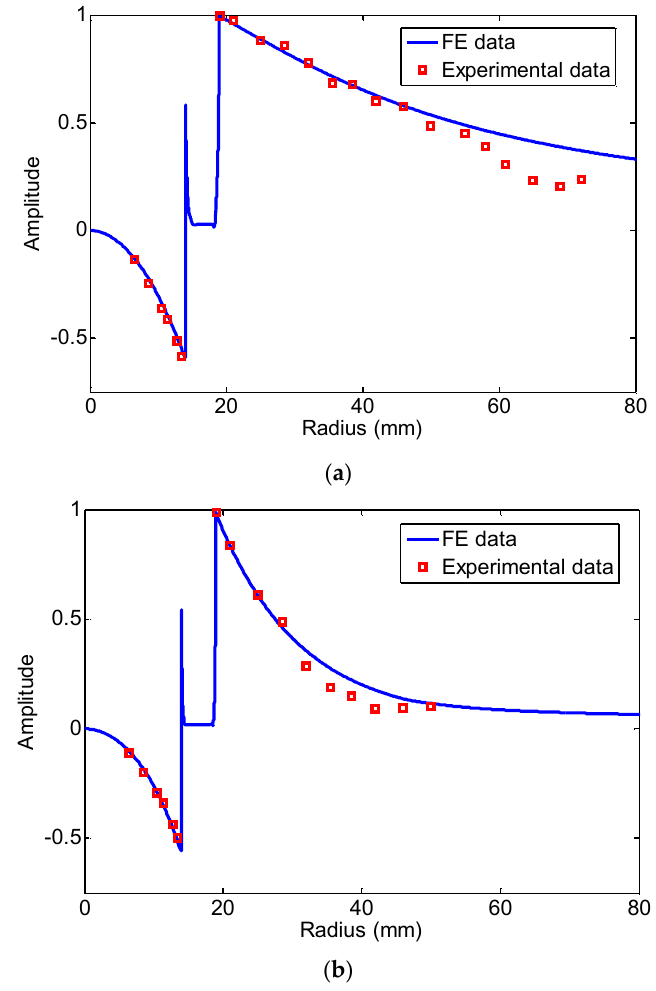
Figure 9. The normalized experimental and FE data of the peak-peak value of the first passing signal: ( a ) 20 kHz; ( b ) 80 kHz.